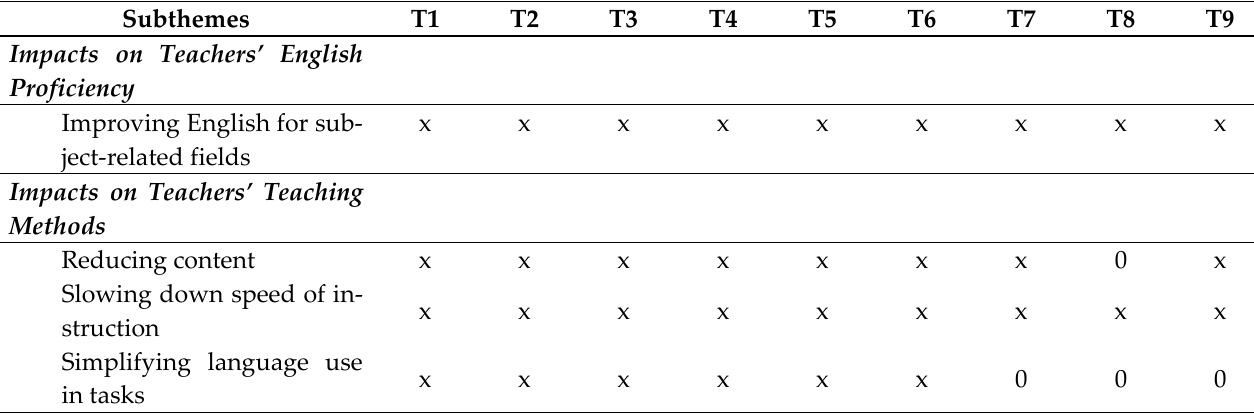
Table 2. Perceived Impacts of EMI on Teaching